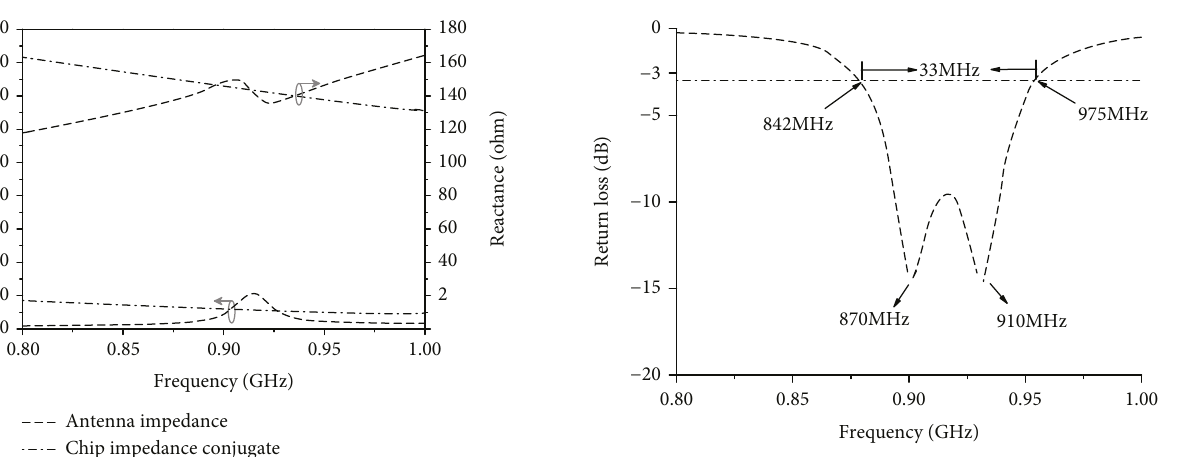
Figure 5: Return loss of the antenna with the optimized